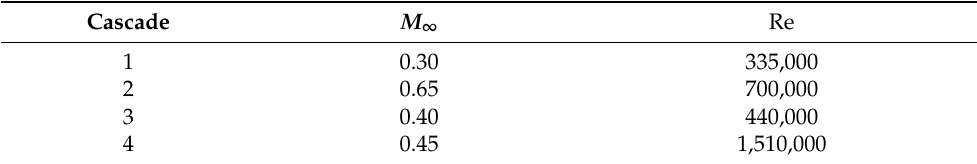
Table 3. Flow conditions for the cascades.